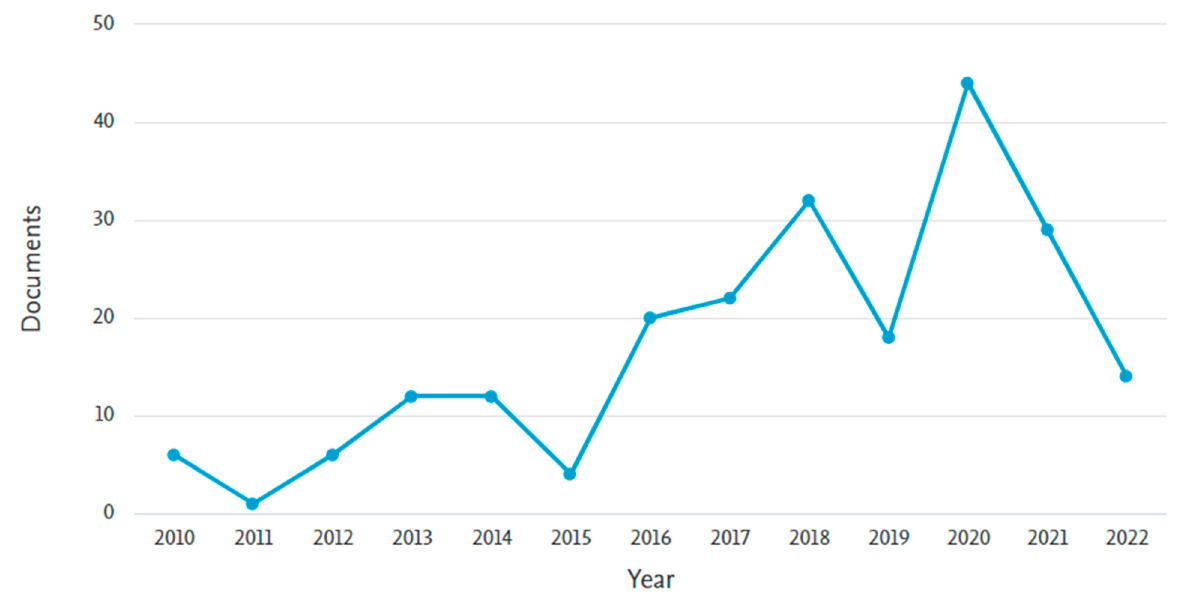
Figure 6. Annual publication trend of articles.